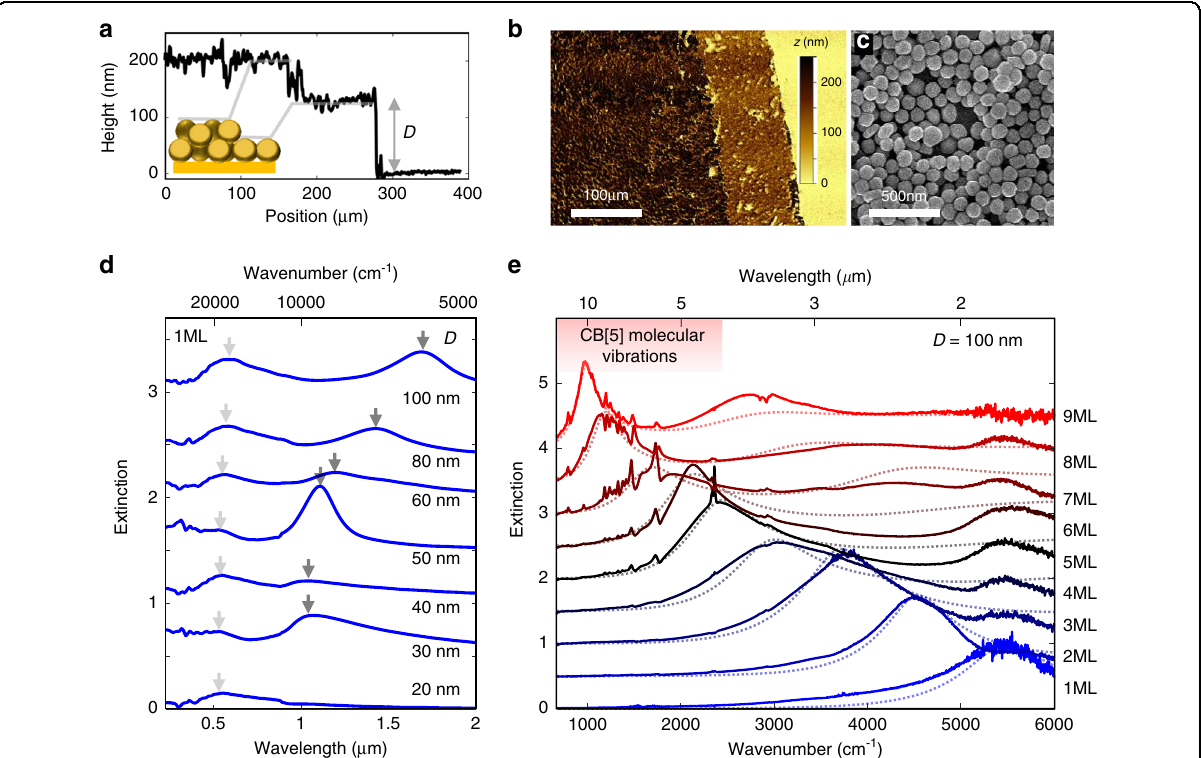
Fig. 1 Optical response of amorphous AuNP multilayers on gold (NP n ML-on-mirror). a Height pro fi le of monolayer (1 ML) and bilayer (2 ML) disordered AuNP ( D = 100 nm) multilayer fi lms from optical pro fi lometer. b Optical pro fi lometer image of monolayer and bilayer fi lms. c Scanning electron micrograph of 2 ML fi lm. d Extinction spectra of 1 ML fi lms with increasing AuNP diameter D = 20 – 100 nm. Arrows mark resonance positions. e FTIR extinction spectrum of NP n ML-on-mirror fi lms for n = 1 – 9 with AuNP diameter D = 100 nm. Red shaded represents spectral region with CB[5] vibrational absorption peaks. All spectra expressed in absorbance units ( − log 10 R ). Dotted lines show fi ts from collective plasmon-polariton model (SI Section